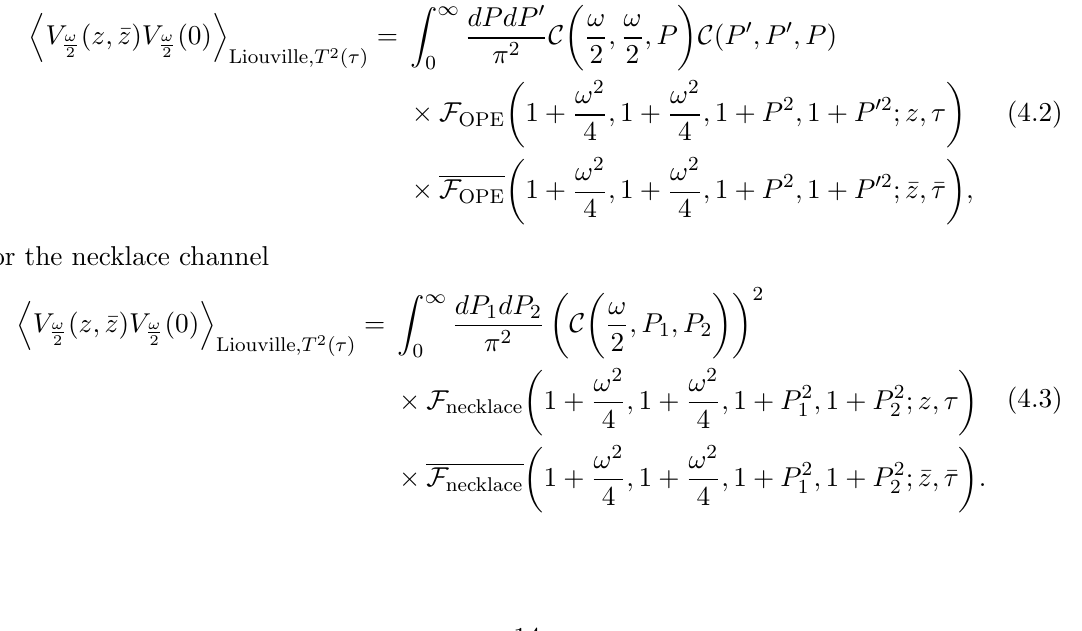
Figure 3 . Numerical results for the real and imaginary parts of the string amplitude for (cid:0) i A (0) (red dots) in comparison to the anticipated analytic result (1.5) (blue dashed line) at the mo- menta (3.24), with varying 0 (cid:20) r (cid:20) 0 : 9. The parameter a that controls the imaginary part of the energies is taken to be a = 1 : 4 in (a), (b) and a = 0 : 2 in (c), (d). The z -integral is regularized as in (3.15) for r > 4 a= 9. The green dashed line in (c), (d) corresponds to (1.5) with Imax f ! j g replaced by the ! j with the largest real part (namely ! 4 for the momenta (3.24)), which clearly deviates from the string